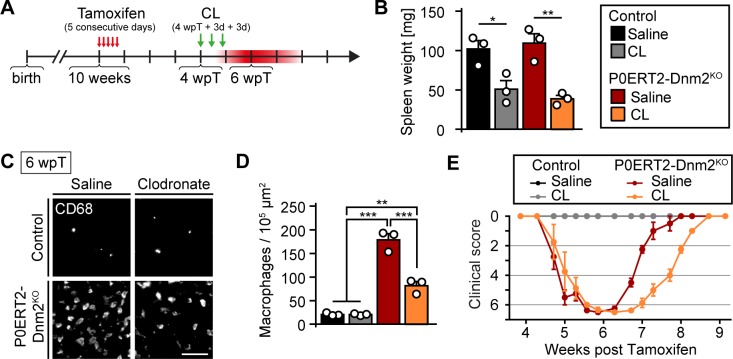
Macrophages are beneficial for recovery after demyelination due to loss of dynamin 2 in adult Schwann cells.(A) Schematic drawing of the experimental timeline. 10 weeks-old control (Dnm2loxP/loxP) and P0ERT2-Dnm2KO (MpzCreERT2:Dnm2loxP/loxP) mice were injected intraperitoneally with tamoxifen on five consecutive days. At 4 wpT, the mice were injected intravenously with clodronate liposomes (CL) or saline (Sal) three times (4 wpT, 4 wpT +3 d, 4 wpT +6 d). (B) Spleen weights in controls and P0ERT2-Dnm2KO at 6 wpT are consistent with effective macrophage deprivation after CL treatment in both genotypes. N = 3 mice/genotype and treatment, One-way ANOVA with Tukey´s multiple comparisons test. (C) Immunostainings for the macrophage marker CD68 on SN cross-sections derived from control and P0ERT2-Dnm2KO mice, treated with CL or Sal, at 6 wpT. N = 3 mice/genotype and treatment. Scale bar = 50 μm for entire panel. (D) Quantification of (C) (random fields). N = 3 mice/condition (color code as in B), One-Way ANOVA with Tukey´s multiple comparisons test. (E) CL- and Sal-treated control and P0ERT2-Dnm2KO mice were phenotypically assessed over a period of 5 weeks. All P0ERT2-Dnm2KO developed a transient moderate paraparesis around 6 wpT. CL-treated P0ERT2-Dnm2KO recovered more slowly compared to Saline-treated P0ERT2-Dnm2KO mice. N = 3 controls and N = 4 P0ERT2-Dnm2KO mice. Clinical score: 0 = normal, 1 = less lively, 2 = impaired righting, 3 = absent righting, 4 = ataxic gait, 5 = mild paraparesis, 6 = moderate paraparesis, 7 = severe paraparesis. Results in graphs represent means ±s.e.m.; *p<0.05, **p<0.01, ***p<0.001.10.7554/eLife.42404.010Figure 3—Figure supplement 2—Source data 1.Phenotypical assessment of control and P0ERT-Dnm2KO mice treated with Clodronate or Saline from day 27 to day 64 post tamoxifen.Refers to panel E.